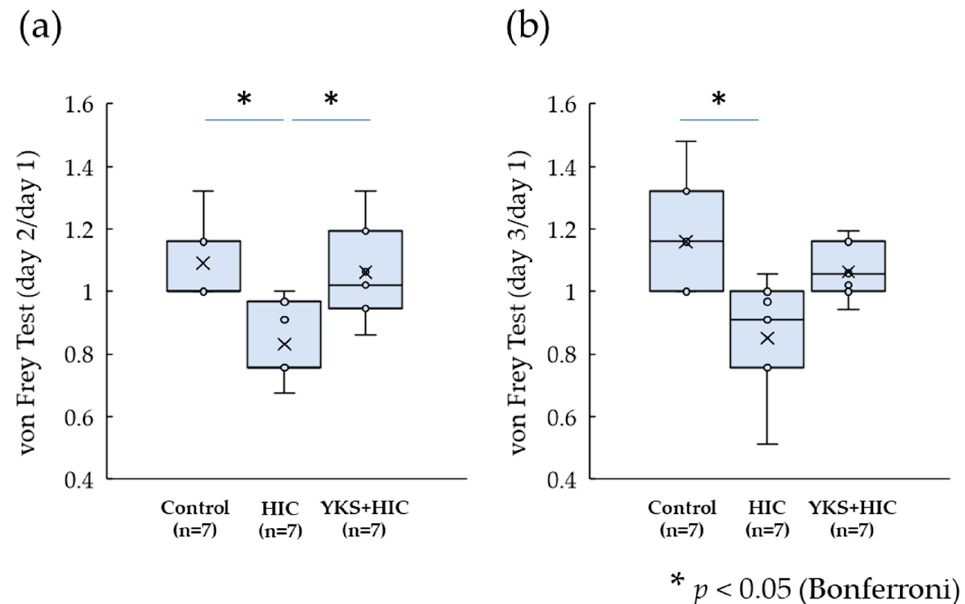
Figure 3. Von Frey Test. The values obtained on day 2 ( a ) and day 3 ( b ) are shown by the rate of change in relation to a baseline value of 1. Horizontal lines within boxes denote median values, and x marks denote the mean values. * Significant difference ( p < 0.05) (Kruskal–Wallis test with post hoc test and Bonferroni correction). HIC, Hunner-type interstitial cystitis; YKS,